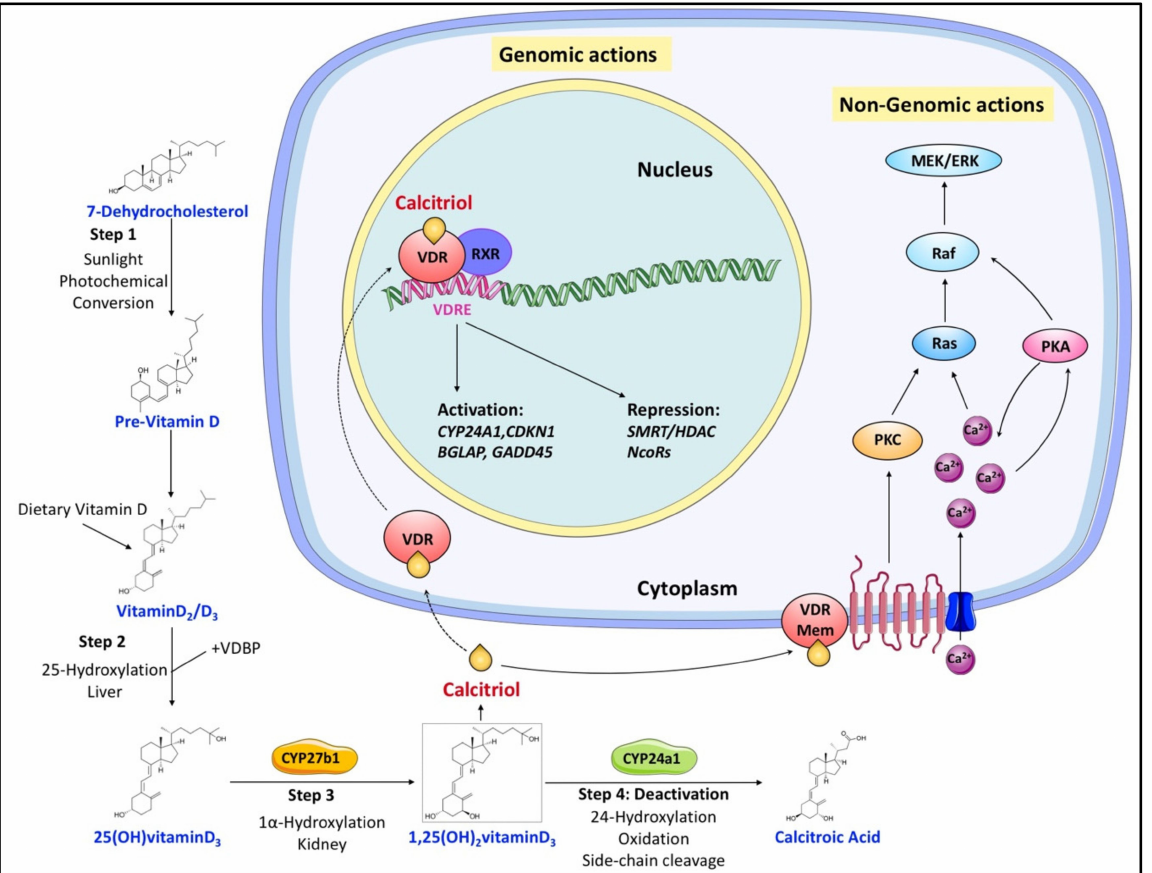
Figure 1. Overview of vitamin D canonical metabolism and its genomic or nongenomic